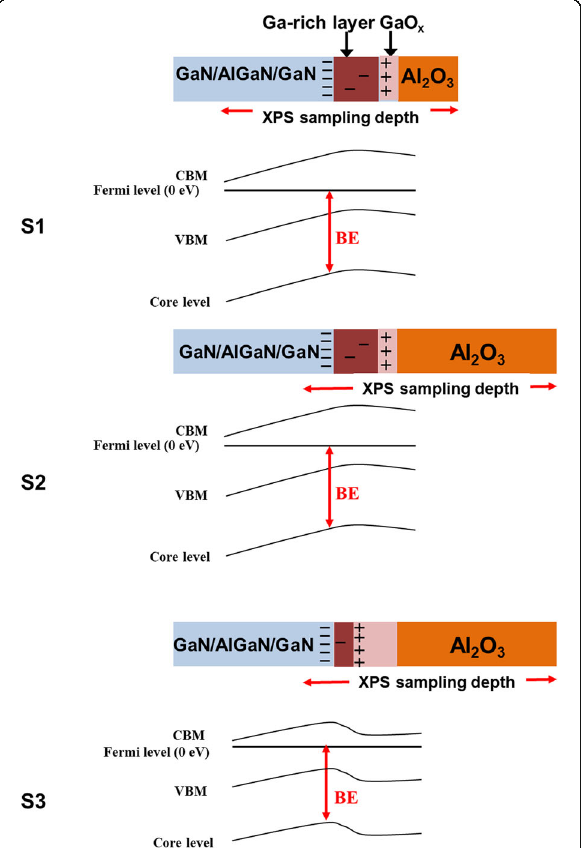
Fig. 4 In the interface region, O replacing N in the Ga – N bond results in a Ga-rich layer and a GaO x layer. The Ga-rich layer acts as the GaN-to-GaO x transition layer. The Ga – O formation eliminates the polarization of GaN and acts as positive charges. As a result, the conduction band bends gradually from upward to downward and the BE varies